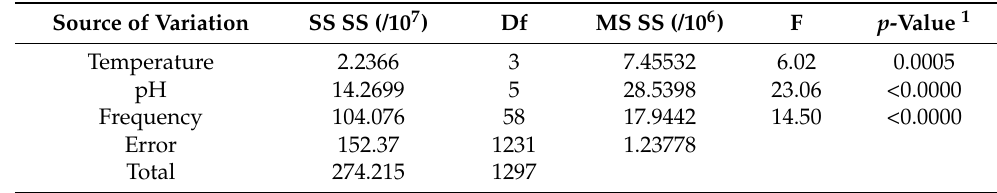
Table 6. Two-Way ANOVA results for the delay with all gathered